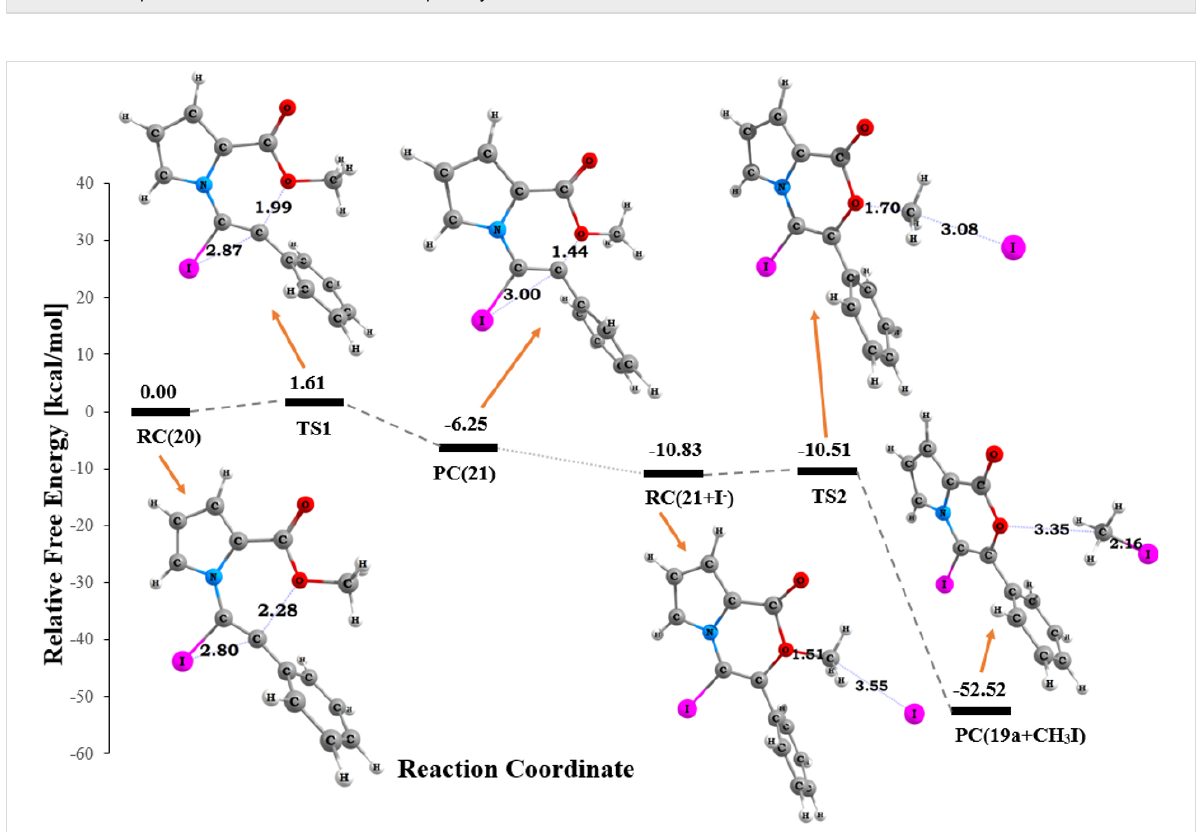
Figure 8: Potential energy pro fi le related to the formation of pyrrolooxazinone 19c in the polarizable continuum model (PCM) [34,35] with the hybrid functional M06 [36] using 6-31+G(d)/LANL2DZ level in dichloromethane. Distances are given in angstroms. (Relative energies shown for 20 , TS1 , and 21